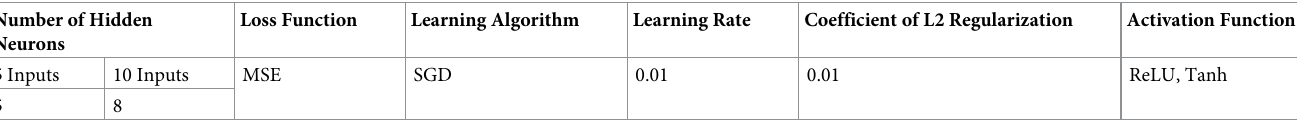
Table 6. Parameters for NNR model with filtered